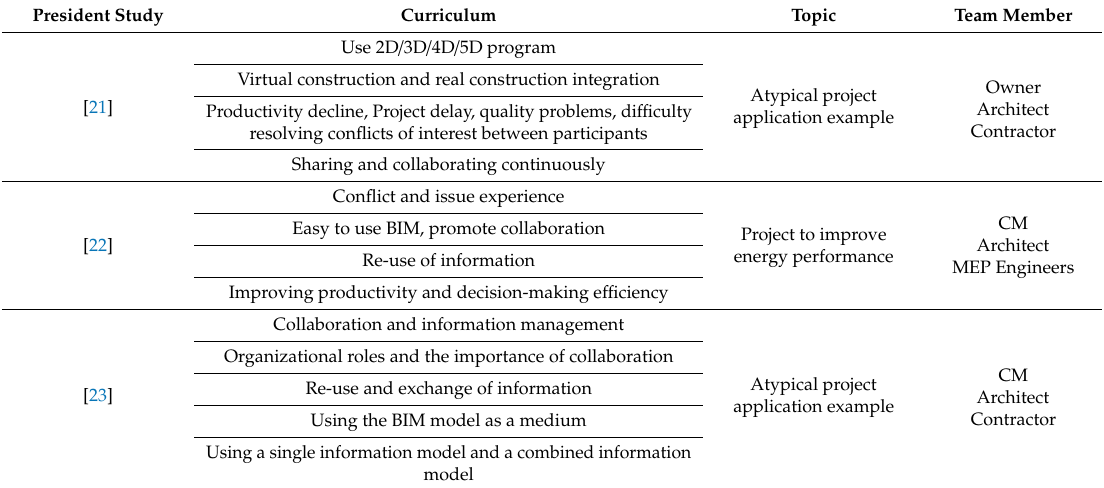
Table 2. Literature survey for integrated project delivery (IPD)